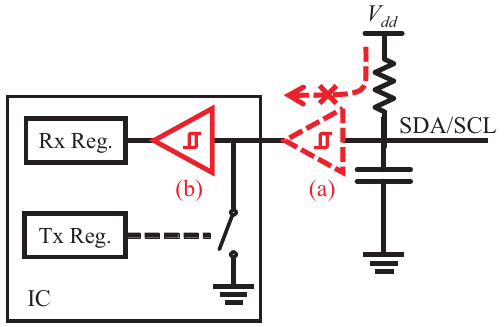
Figure 5. We expect that the waveshaping module is put at the place (a) outside the chip, but the module will block the current so that the chip cannot transmit data to the bus. The placement (b) on the receive branch is adequate, but it requires modifying the chip